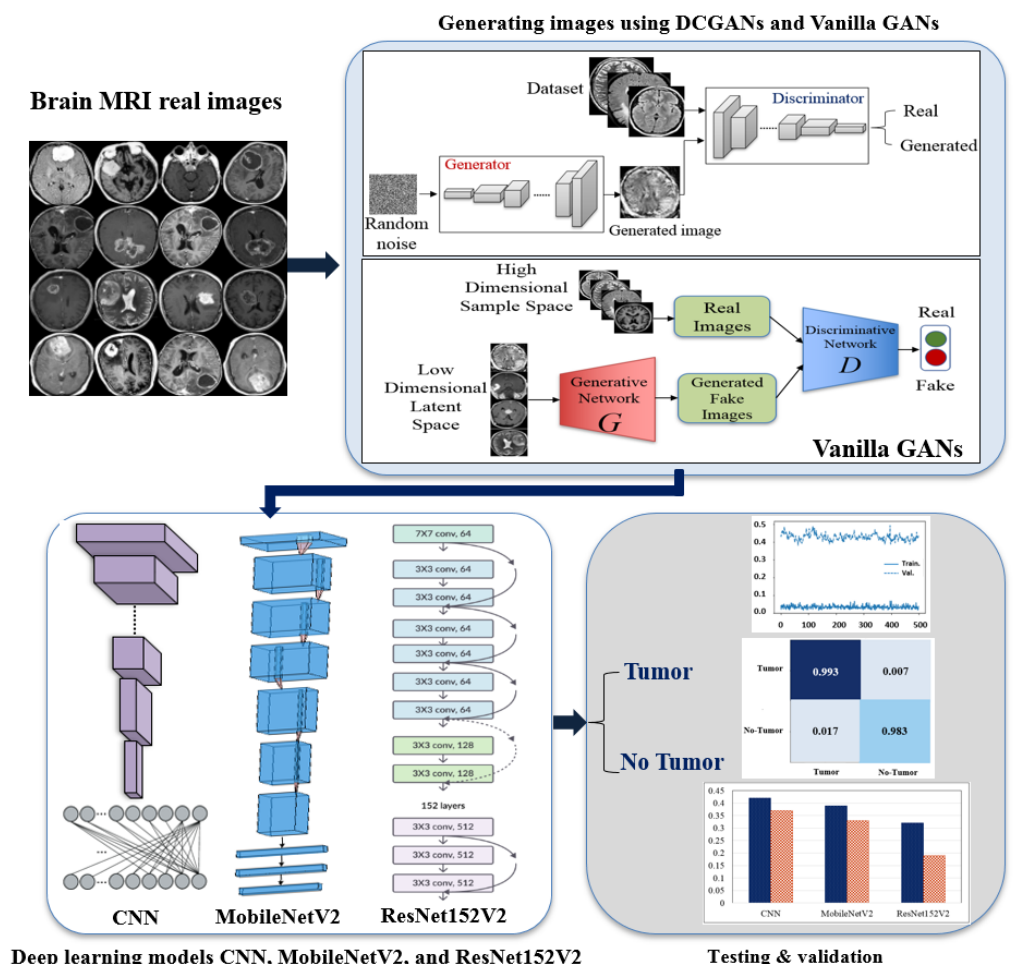
Figure 1. Our proposed BrainGAN framework starting with Brain MRI dataset real images, generating images using DCGAN and Vanilla GAN, deep learning models CNN, MobileNetV2, and ResNet152V2, and finally the testing & validation.